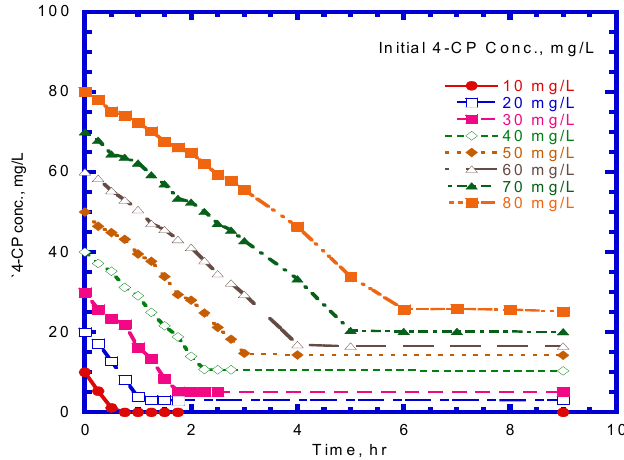
Figure 5. Effect of initial 4-CP concentration on transformation of 4-CP by resting cells with initial cell concentration of 93.4 mg/L.